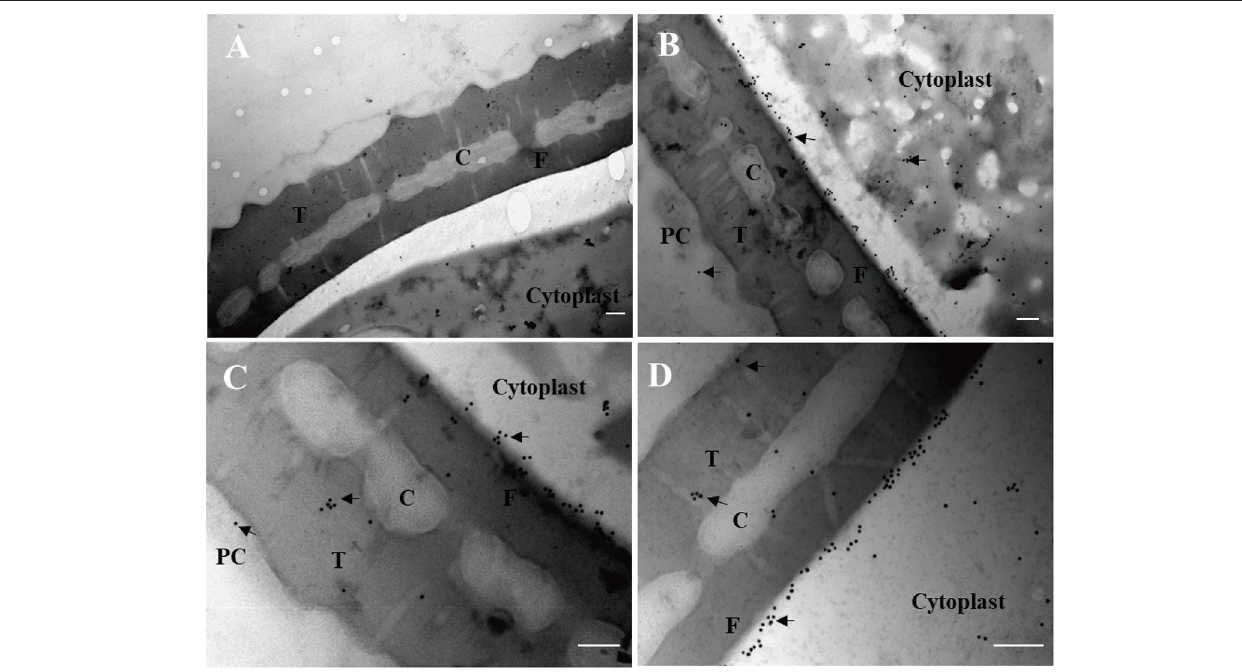
FIGURE 9 | Subcellular localization of ZmCP03 in maize pollen by immunogold electron microscopy. (A) Negative control, preimmunized rabbit serum, and then incubated with 15-nm gold-conjugated anti-rabbit lgG (1:20, 45min); (B – D) sections of maize pollen grains were probed with anti-CP (1:100 dilution, 4 ◦ C, overnight); arrows indicate the presence of ZmCP03; PC, pollen coat; T, tectum layer, C, columella; F, foot layer; The exine consists of the tectum layer, foot layer, and columella. Scale bar = 200nm.